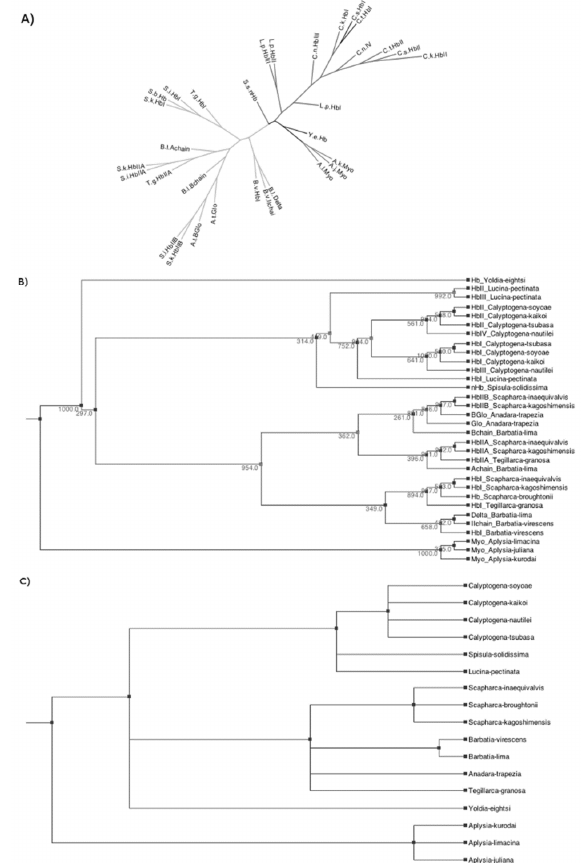
Figure 3. ( A ) Maximum-likelihood tree of based on 32 mollusk globin sequences with 1000 bootstraps (bootstrap values are shown in the reconciled tree). ( B ) Gene Tree. A rooted-species-reconciled phylogenetic gene tree was constructed using PHYLIP, followed by reconciling the gene tree with the species tree and rooting using NOTUNG, as described in Materials and Methods. Numbers represent the bootstrap values from the Maximum Likelihood phylogenetic analysis. ( C ) Species tree. A rooted species phylogenetic tree was built using the Taxonomy resource at NCBI and verified using the Tree-of-Life resource at http://tolweb.org (accessed on 12 November 2018). The ML phylogenetic tree divides these globin sequences in three main clusters: Bi- valves belonging to the Heterodonta subclass; Bivalves belonging to the Pteriomophia subclass; and the Gastropods belonging to the Opisthobranchia subclass. We can group the globin sequences according to the clade that they belong to, and examine the amino acid conservation within each group (Figure 4).